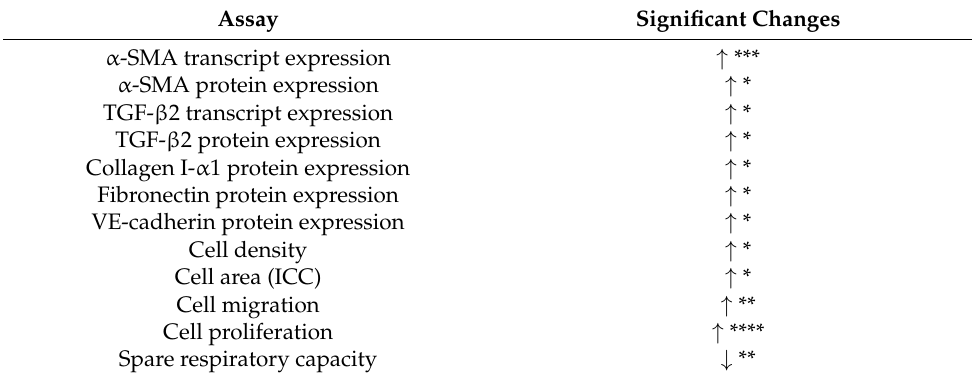
Table 1. Summary of significant changes observed between gSCECs and SCECs. This table sum- marises the statistically significant changes observed in gSCECs, compared to SCECs. ↑ represents an increase or upregulation observed in gSCECs, compared to SCECs. ↓ represents a decrease or downregulation observed in gSCECs, compared to SCECs. Statistical significance is indicated by the following * = ( p < 0.05), ** = ( p < 0.01), *** = ( p < 0.001), and **** = ( p < 0.0001). Assay Significant Changes α -SMA transcript expression ↑ *** α -SMA protein expression ↑ * TGF- β 2 transcript expression ↑ * TGF- β 2 protein expression ↑ * Collagen I- α 1 protein expression ↑ * Fibronectin protein expression ↑ * VE-cadherin protein expression ↑ * Cell density ↑ * Cell area (ICC) ↑ * Cell migration ↑ ** Cell proliferation ↑ **** Spare respiratory capacity ↓ **